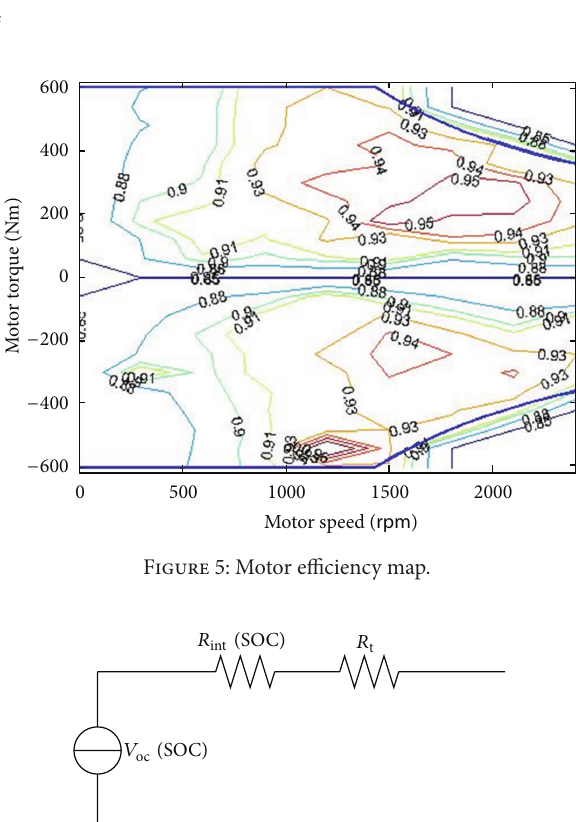
Figure 6: Internal resistive battery